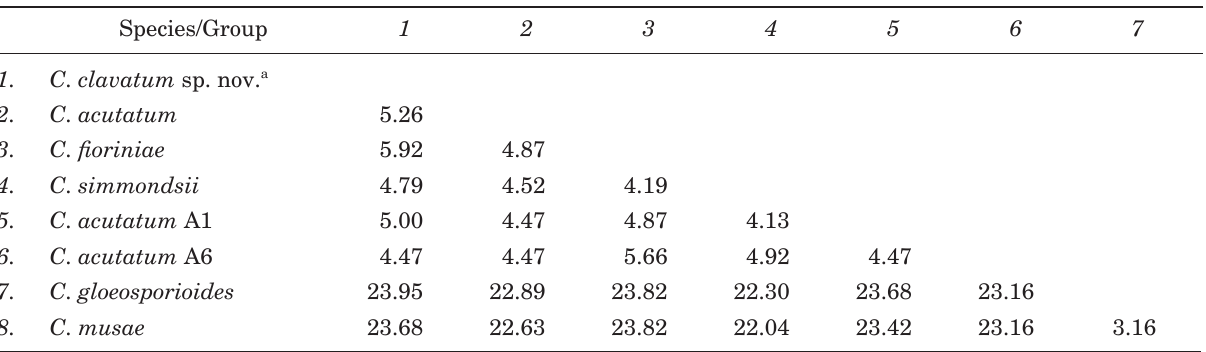
4. Average pairwise percent sequence divergence among Colletotrichum spp. based on 101 nucleotide sequences of the β -tubulin 2 partial